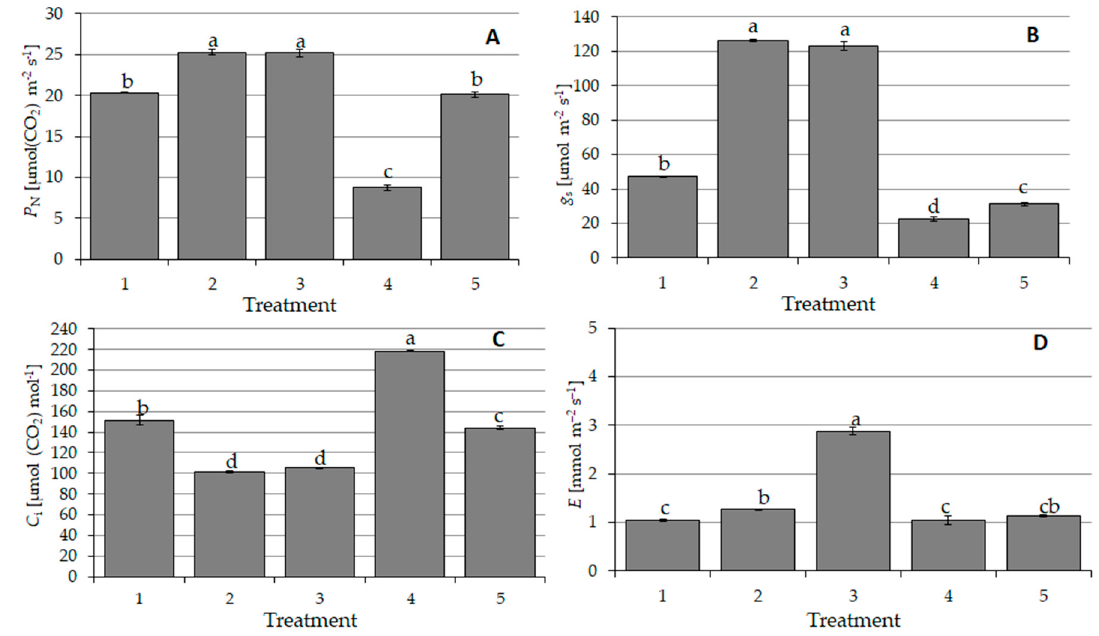
Figure 6. Gas exchange parameters (means ± SE): net photosynthesis rate—P N ( A ), stomatal conductance— g s ( B ), intercellular carbon dioxide (CO 2 ) concentration— C i ( C ) and transpiration rate—